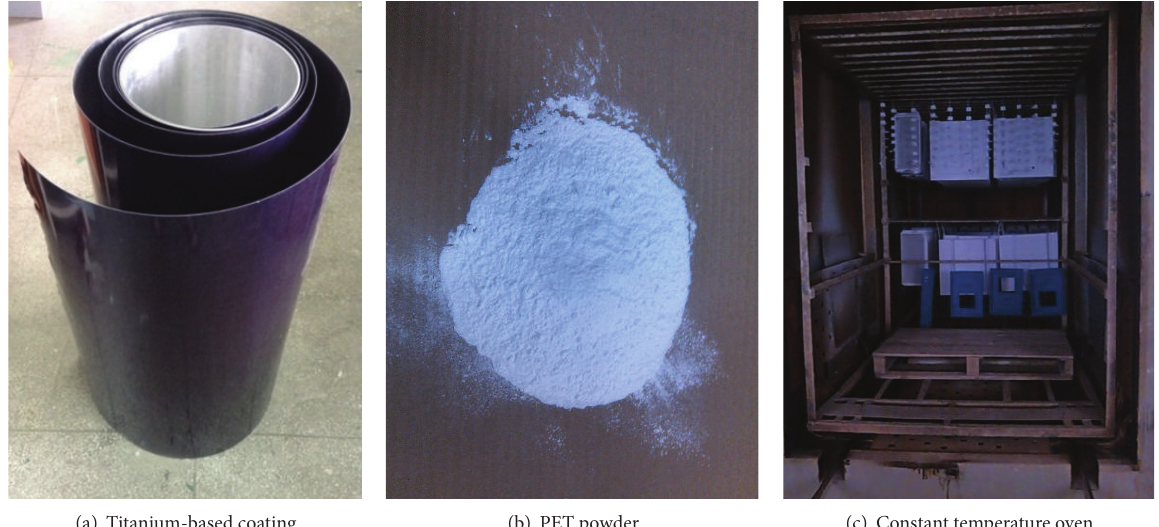
Figure 1: Materials and processing facility of the TPET